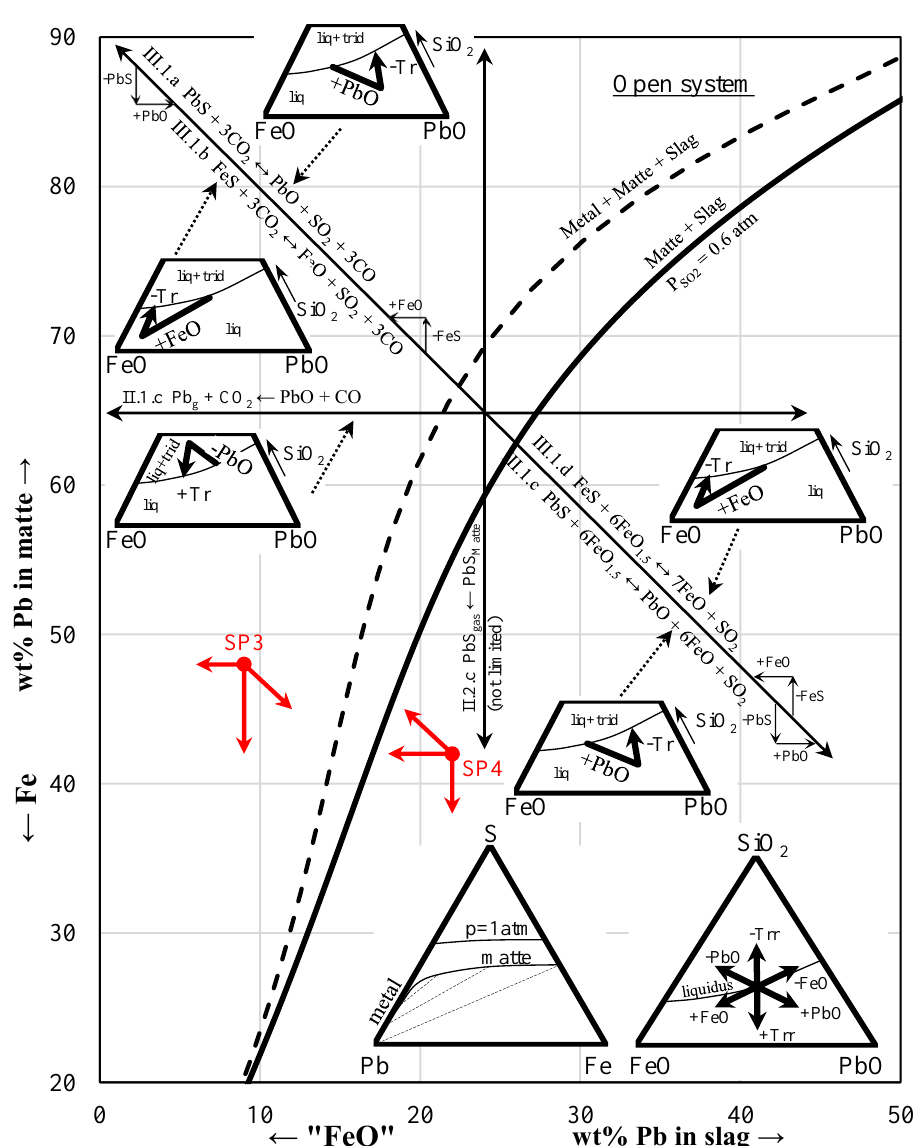
Figure 8. Compositional change direction diagrams for Pb matte vs. Pb slag and PbO-“FeO”-SiO 2 with the vectors of the compositional changes (red arrows) indicating possible changes in matte and slag compositions corresponding to each reaction in the open system.